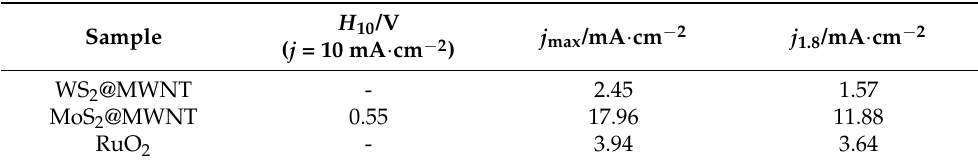
Table 2. OER (oxygen evolution reaction) activity parameters ( η 10 , j max , and j 1.8 ) for WS 2 @MWNT, MoS 2 @MWNT and RuO 2